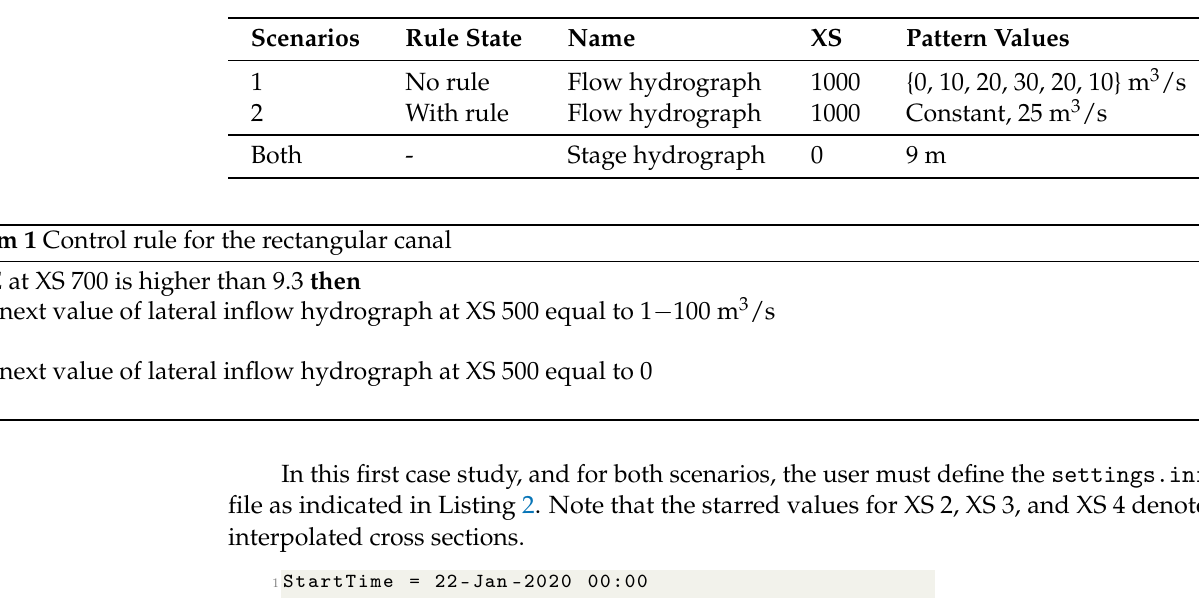
Table 3. Boundary conditions of the rectangular canal.